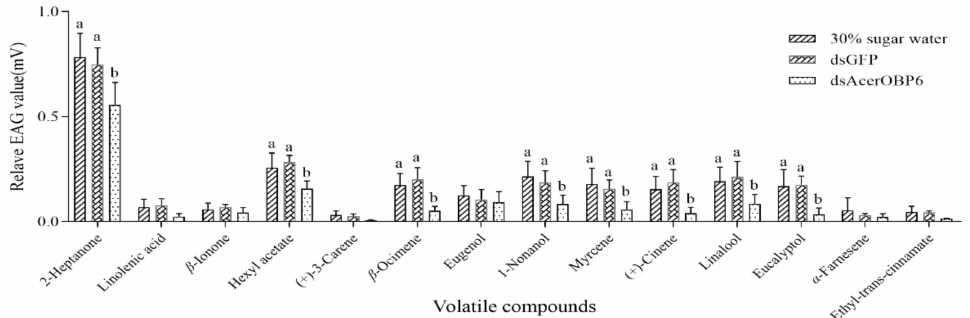
Figure 5. Normalized EAG response of worker bee antennae to selected ligands before and after feeding dsOBP6. The error bars represent the mean ± standard error. Means with different lowercase letters indicate significant differences between three treatment groups of each volatile ( p <